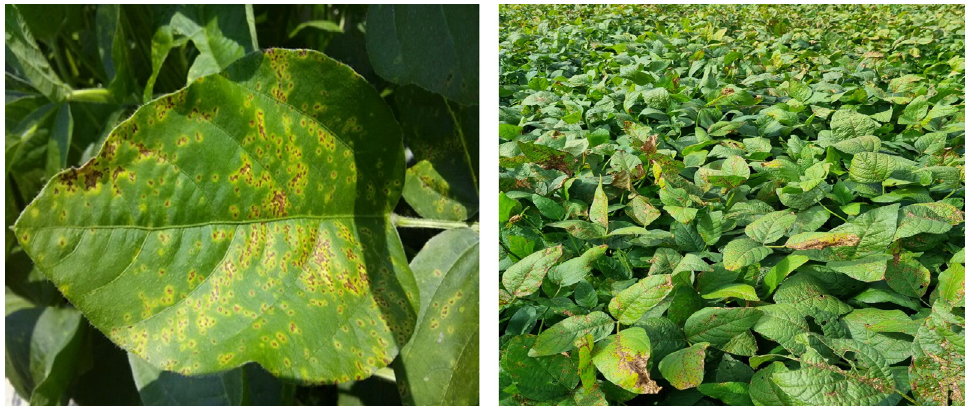
Figure 1. Bacterial pustule symptom caused by Xanthomonas citri pv. glycines on a susceptible soybean genotype.